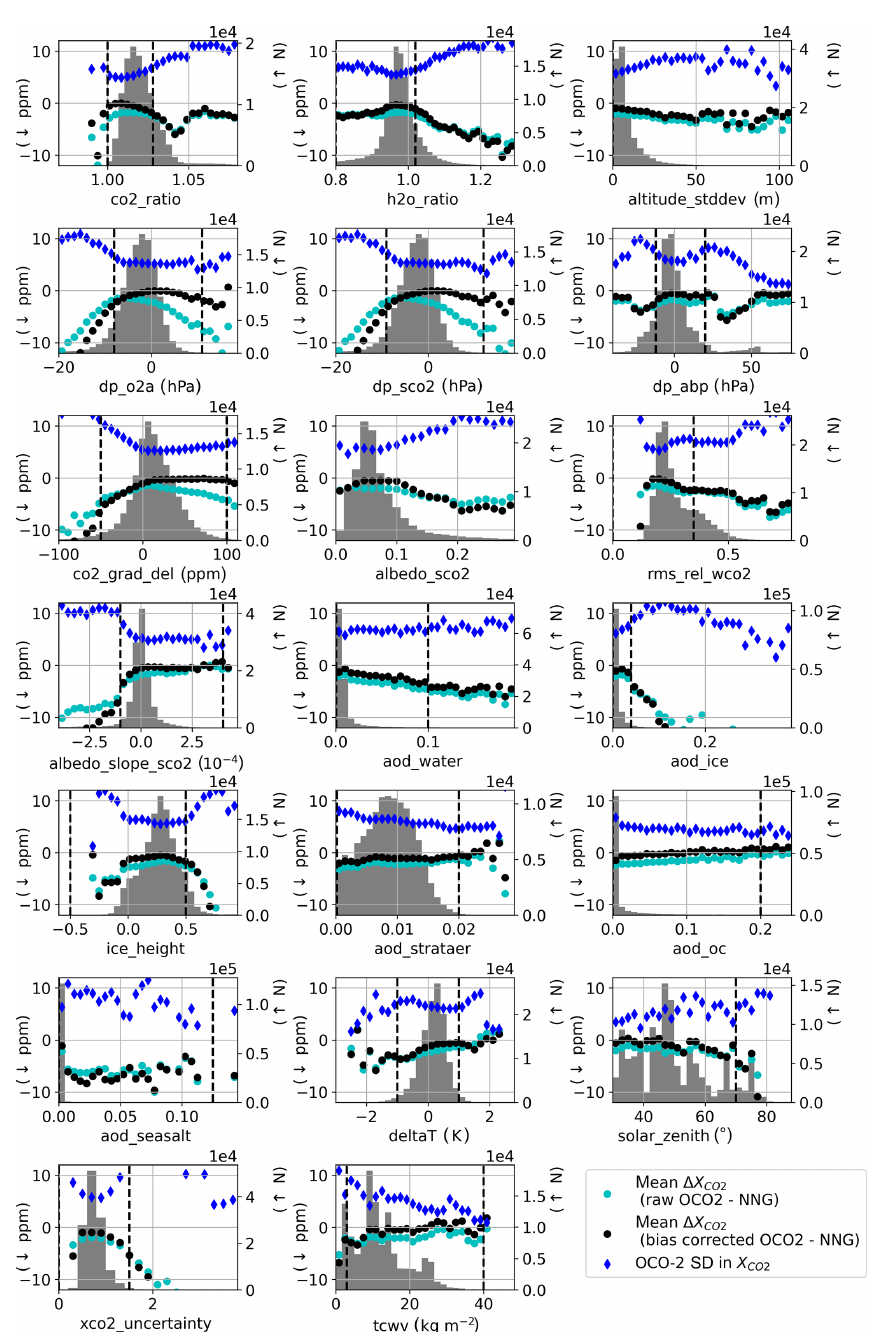
Figure A1. Histograms of retrieval parameters used in the boreal QC and considering only retrievals coincident to the three boreal forest sites in this paper. These plots are in the same style as those presented by O’Dell et al. (2018) but with NNG measurements as truth. Biases in X CO with and without the standard B9 bias correction, and the standard deviation in OCO-2-retrieved X CO 2 units of ppm). Implemented boreal QC thresholds for each parameter are represented by the black dashed vertical